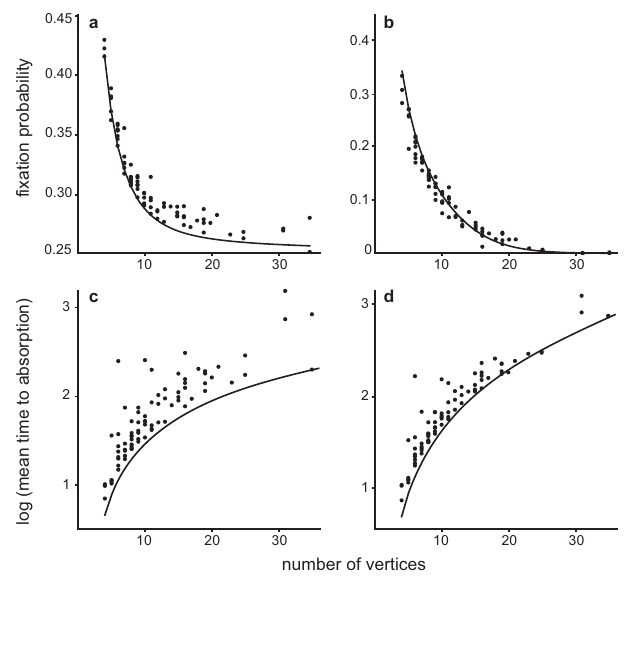
= 5 and a value B